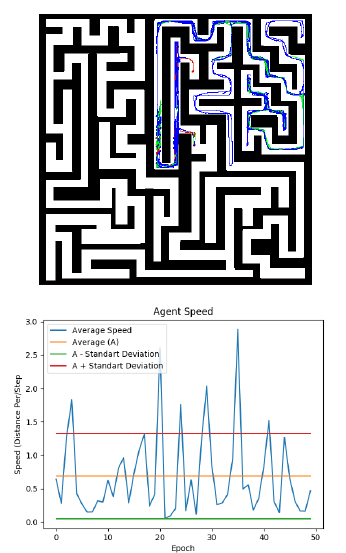
Figure 17. (a) The agent emotional state, and (b) the agent speed with the emotional model’s configurations equal to that shown in row 4 of Table 5.